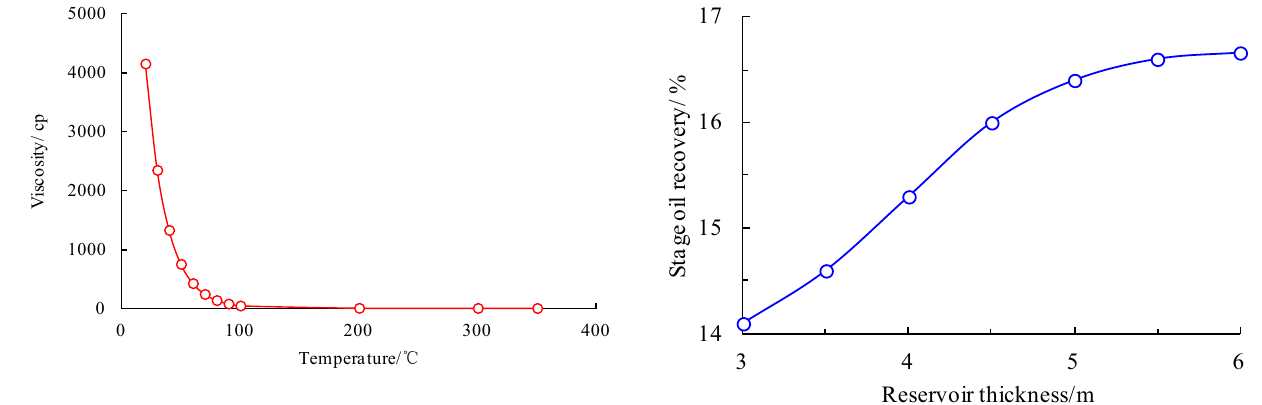
Fig. 5 Viscosity–temperature relationship of the oil sample Table 2 Basic physical parameters of the numerical model